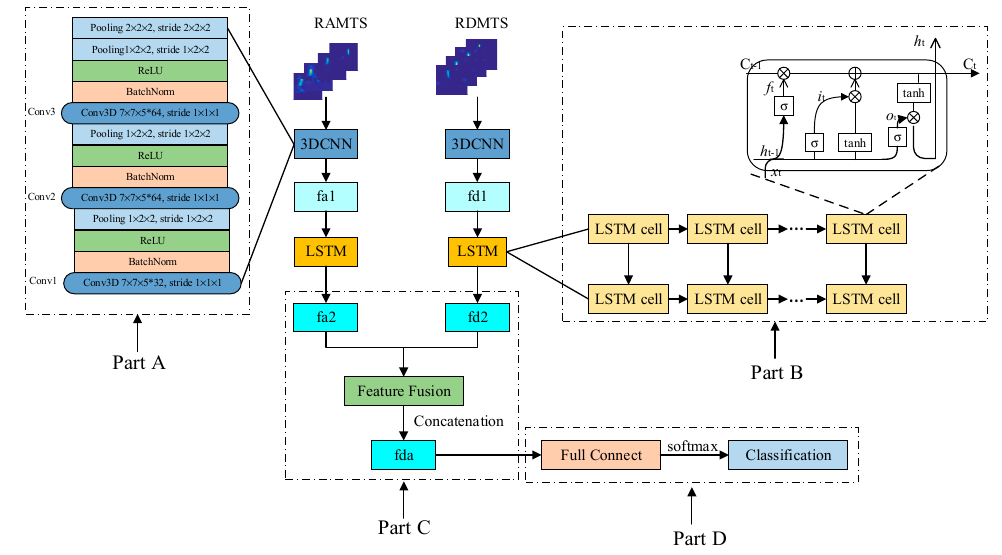
Figure 8. An overview of DS-3DCNN-LSTM network. Part A: 3DCNN structure; Part B: Long Short Term Memory (LSTM) structure; Part C: feature fusion; Part D: classification.